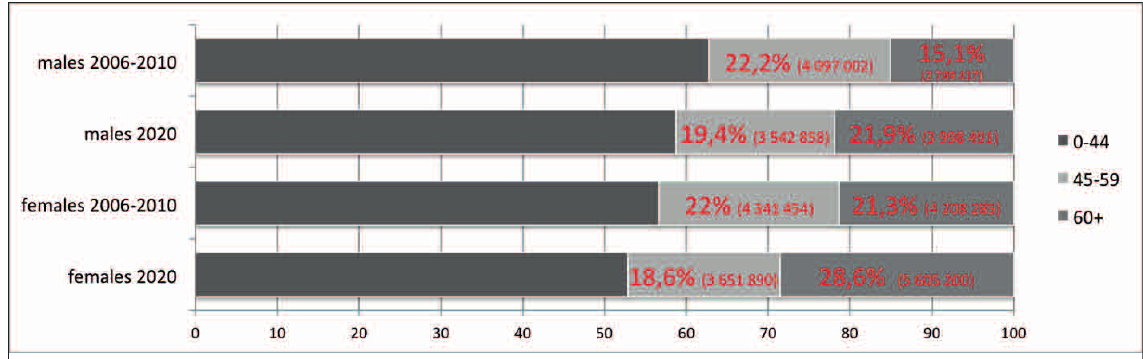
Figure 5. Demographic prognosis for